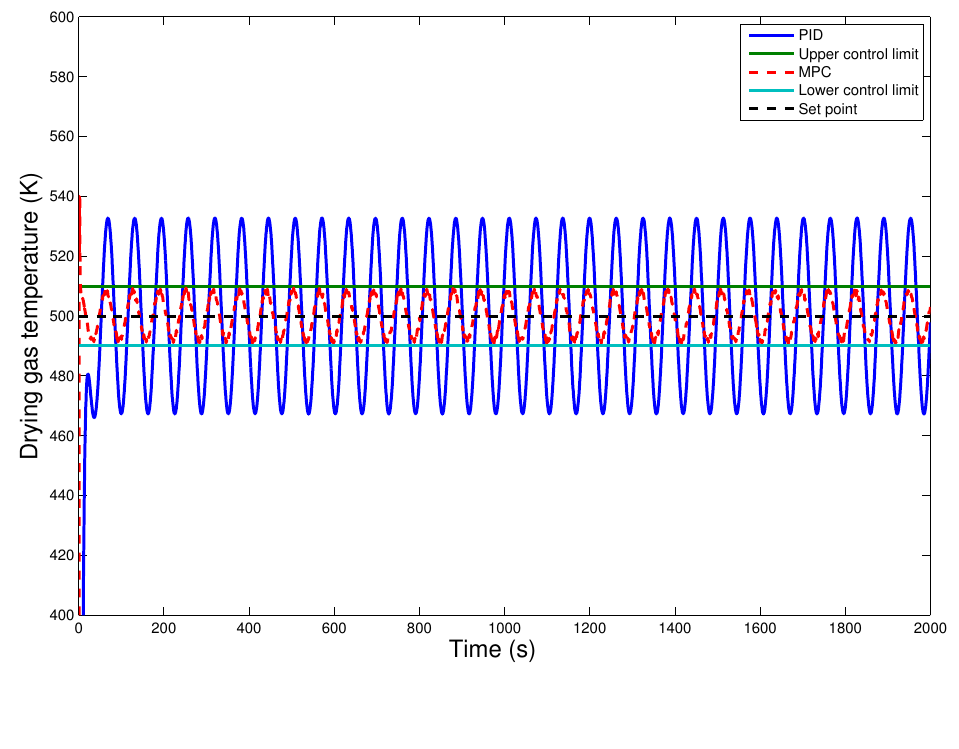
Figure 9. The disturbance rejection ability of controllers for the drying gas temperature.